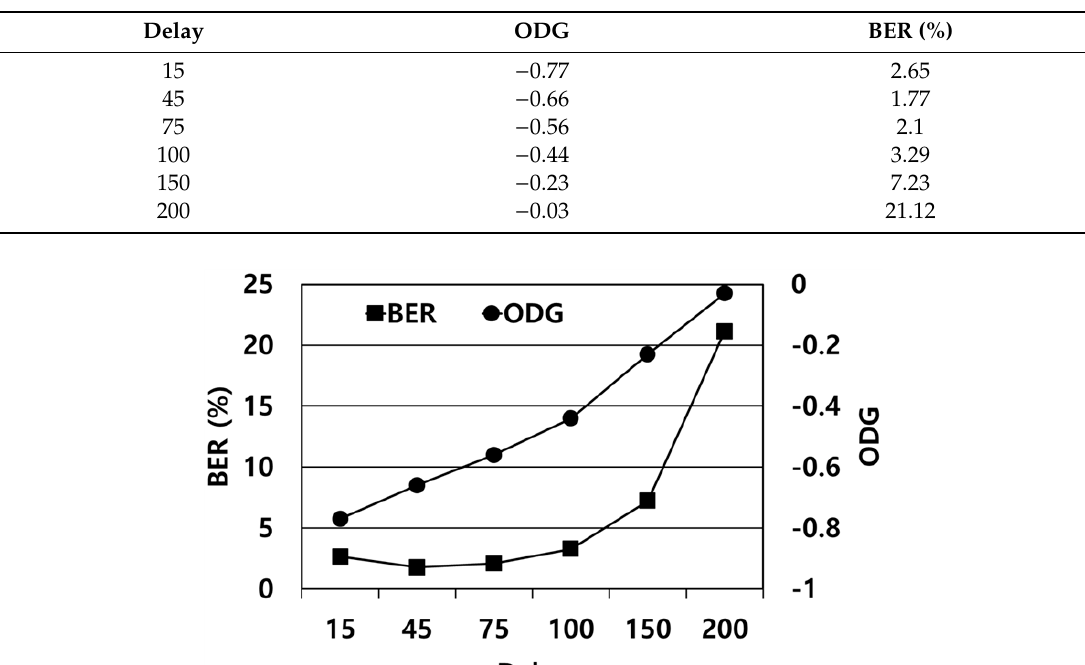
Table 4. ODG and BER values under various delays.